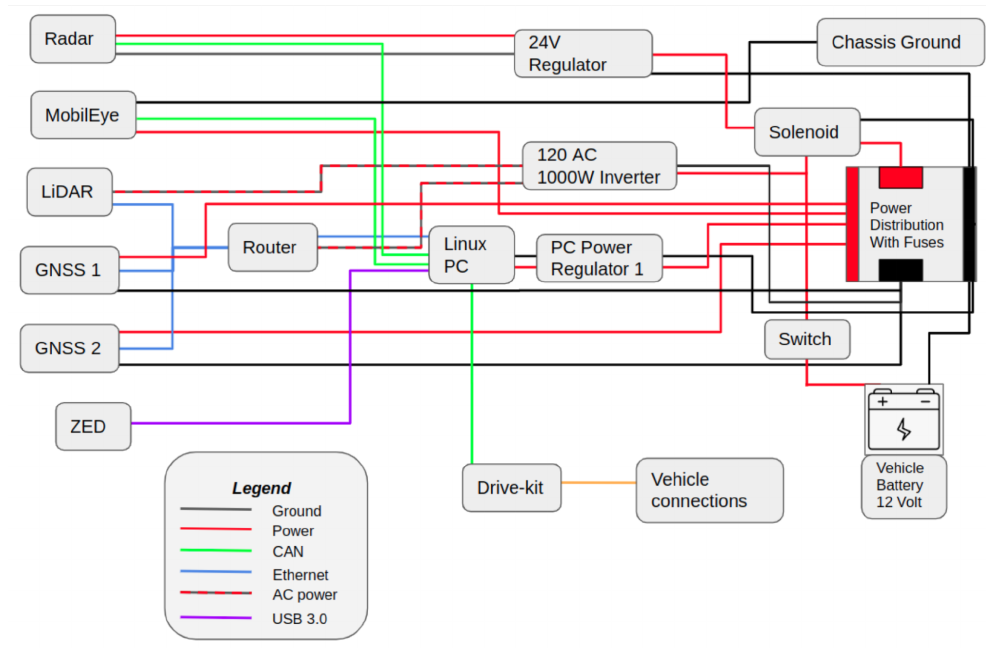
Figure 12. Wiring diagram showing the power connection as well as the type of connection for each sensor and hardware